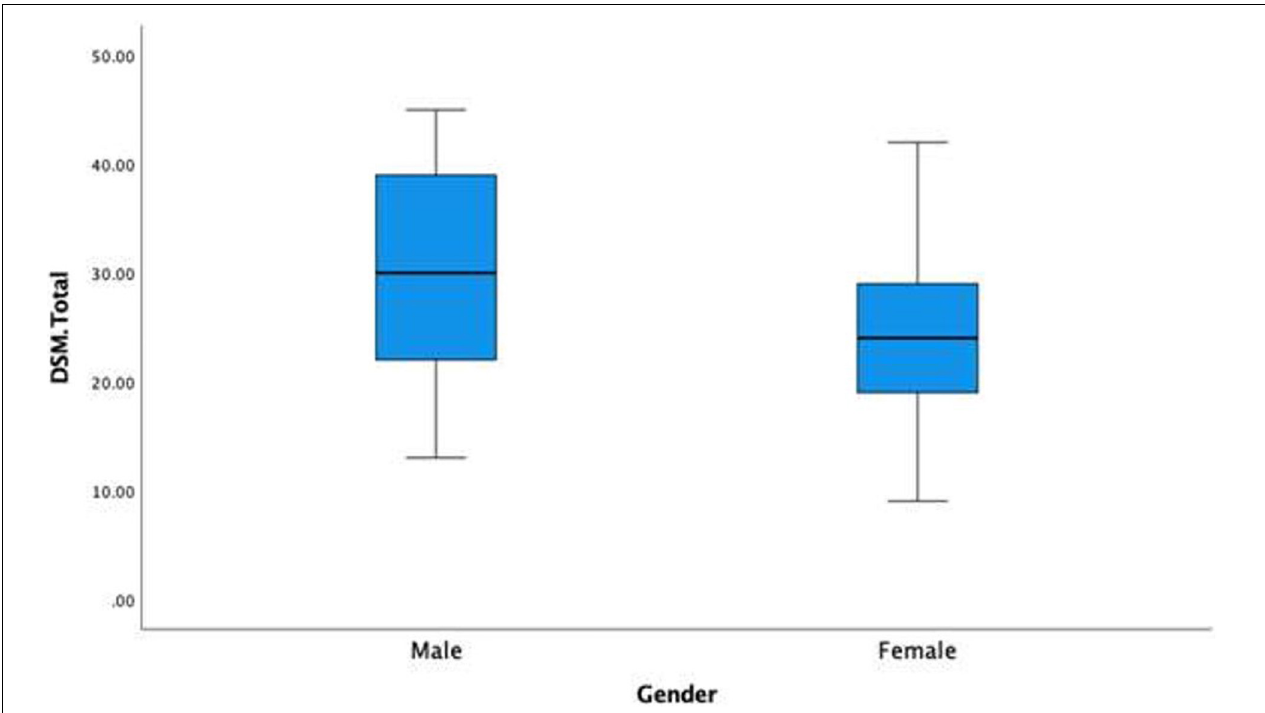
FIGURE 2 | Boxplot of the means and SDs of internet gaming disorder (IGD) scores based on gender.